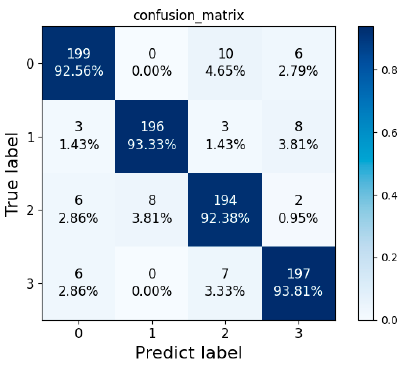
Figure 15. Lian-VGG classification model.